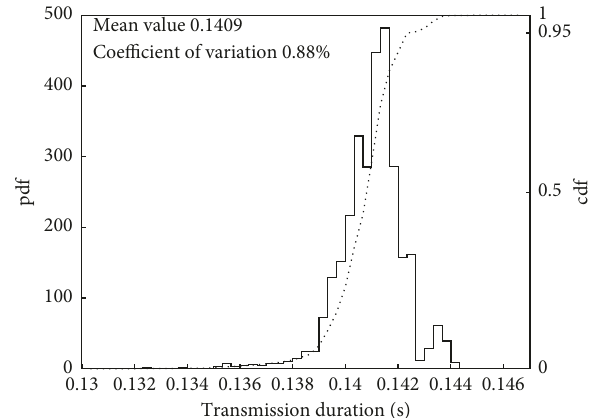
Figure 6: Statistical analysis of the transmission